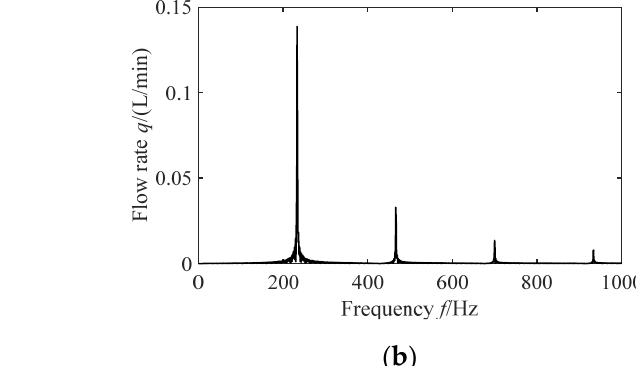
Figure 9. Flow pulsation excitation (flow velocity is 8 m/s). ( a ) Pulsation curve in time domain. ( b ) Pulsation curve in frequency domain.